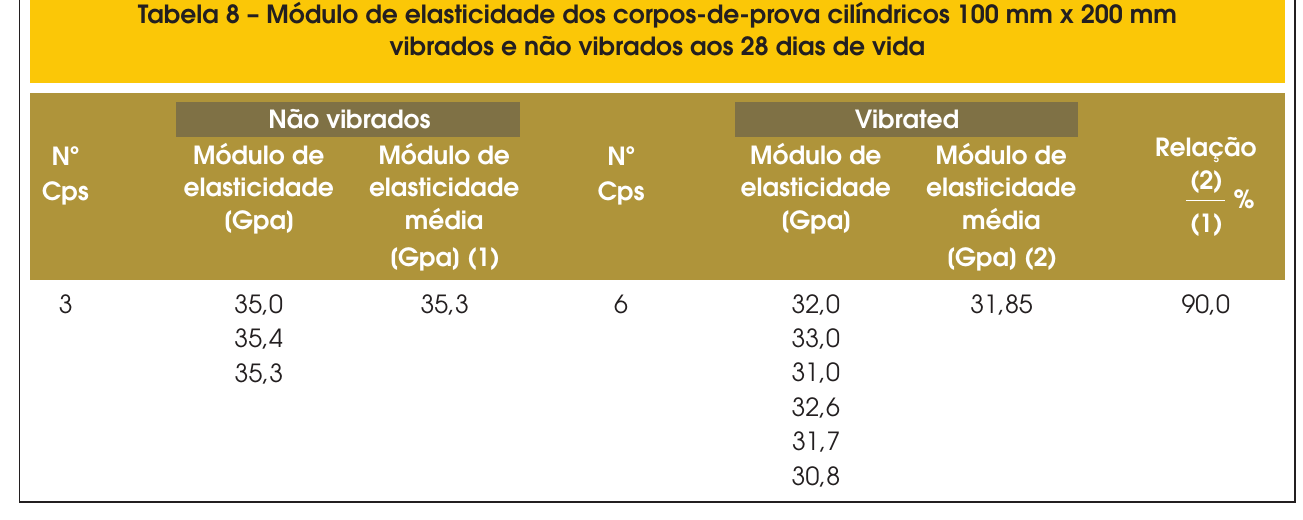
cada corpo-de-prova vibrado e não vibrado com as armaduras po - sicionadas na horizontal ou na vertical. As Figuras 3 e 4 ilustram gráficos comparativos tensão de ade - rência por deslizamento para os corpos-de-prova vibrados e não vibrados com a armadura posicionada na horizontal e na vertical, respectivamente. As curvas são a média de dois a três corpos-de - -prova para cada modelo.